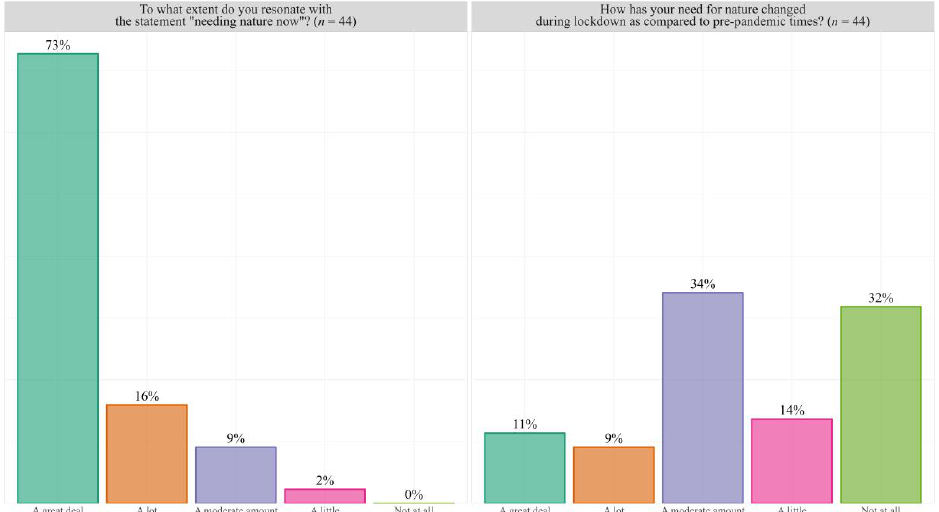
Figure 9. The responses to two questions of the online survey. The questions were: to what extent do you resonate with the statement “needing nature now”, and how has your need for nature changed during the lockdown compared to the pre-pandemic